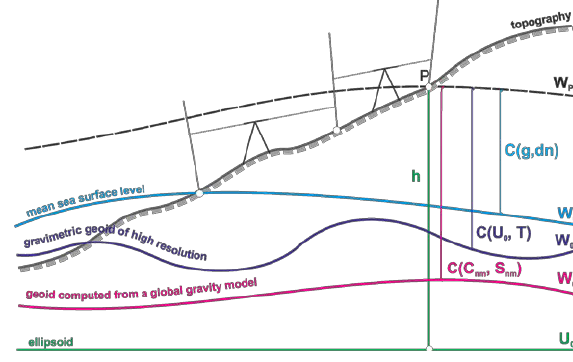
Figure 5. Referencelevelsonlandareasdependingontheinputdata and methods for the determination of vertical coordinates (potential